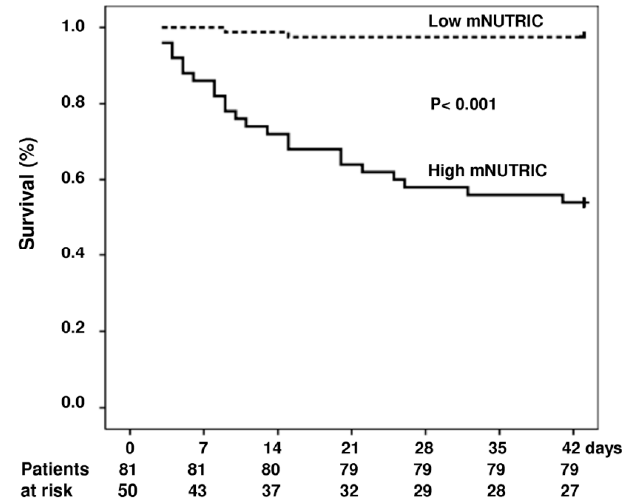
Figure 3. Cumulative survival in patients with and without adrenal insufficiency (dash curve, low mNUTRIC score group, n = 81; solid curve, high mNUTRIC group, n = 50). Probability of survival was significantly lower in patients with high mNUTRIC.